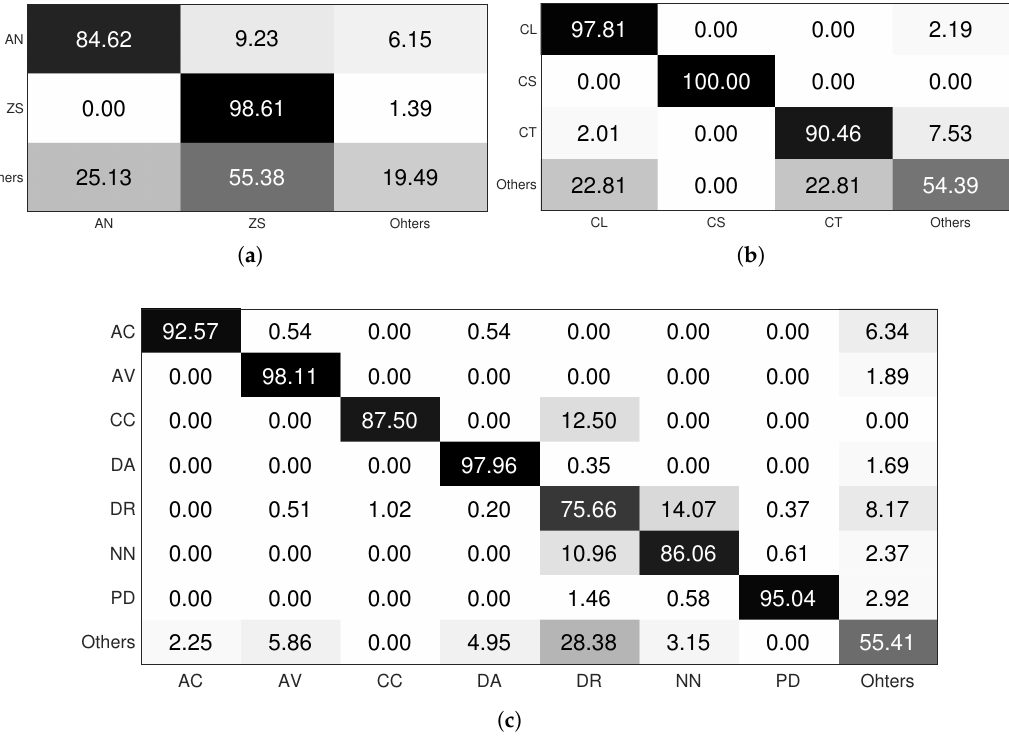
Figure 13. Leaf node confusion matrices for the LCF-15 dataset: ( a ) Acanthuridae node, ( b ) Chaetodontidae node and ( c ) Pomacentridae node. Finally, Figure 14 shows the confusion matrix of the whole hierarchical model. The hi- erarchical model achieves an accuracy of 81.53% (Table 6). According to the confusion matrix, the majority of the species are well-classified, including the difficult species. There- fore, we have significantly improved the classification performance compared with the flat classification, in which we obtained an accuracy of 78.47%.